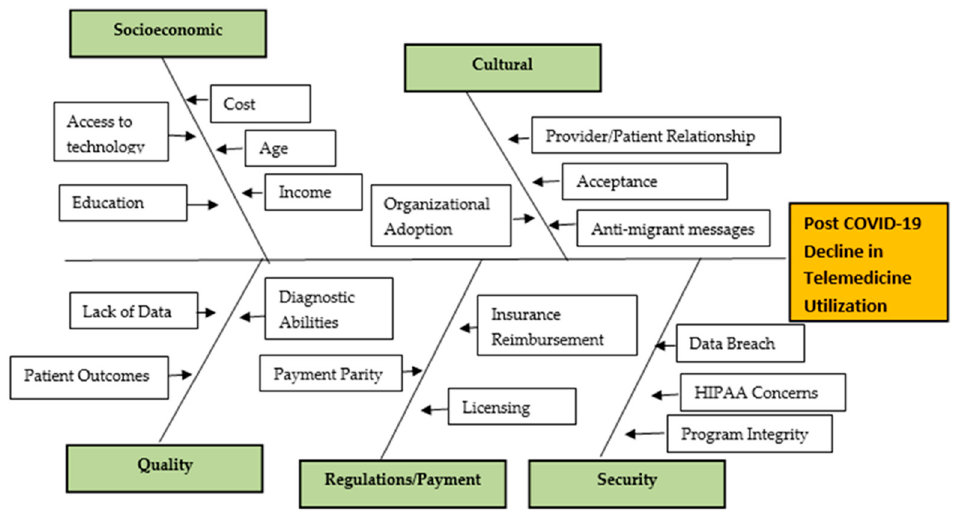
Figure 3. Fishbone